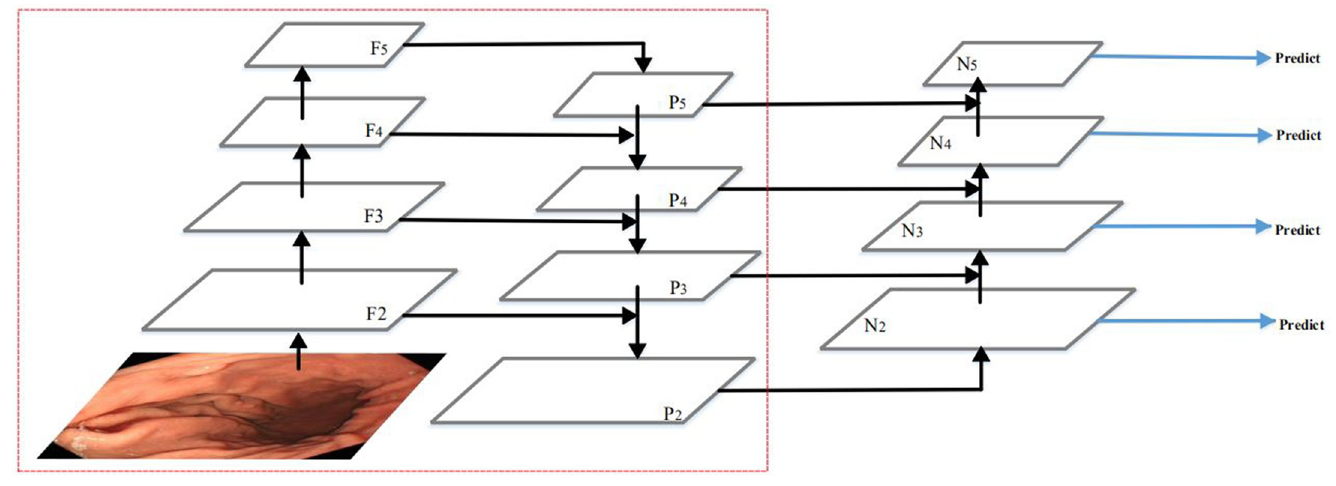
Fig 8. Structure of